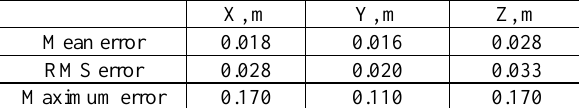
Table 8. Absolute accuracy estimation of MLS data adjustment